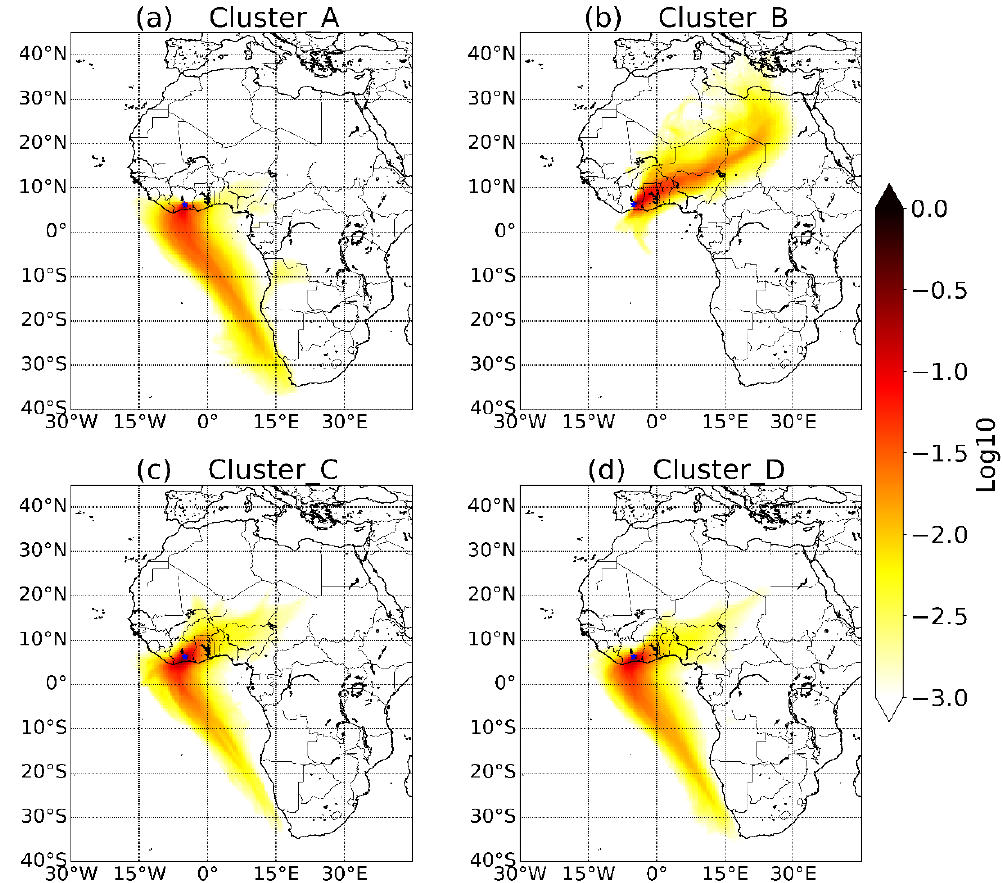
Figure 7. Average PES in each cluster; logarithmic color scale shows the log 10 of residence time, i.e., the PES below 2000 m. ( a – d ): Cluster A–D. Table 3. Variations in CO 2 , CH 4 , and CO statistically associated with the different clusters. The concentration ratios ΔCO/ΔCH 4 and ΔCO/ΔCO 2 associated with the different clusters.